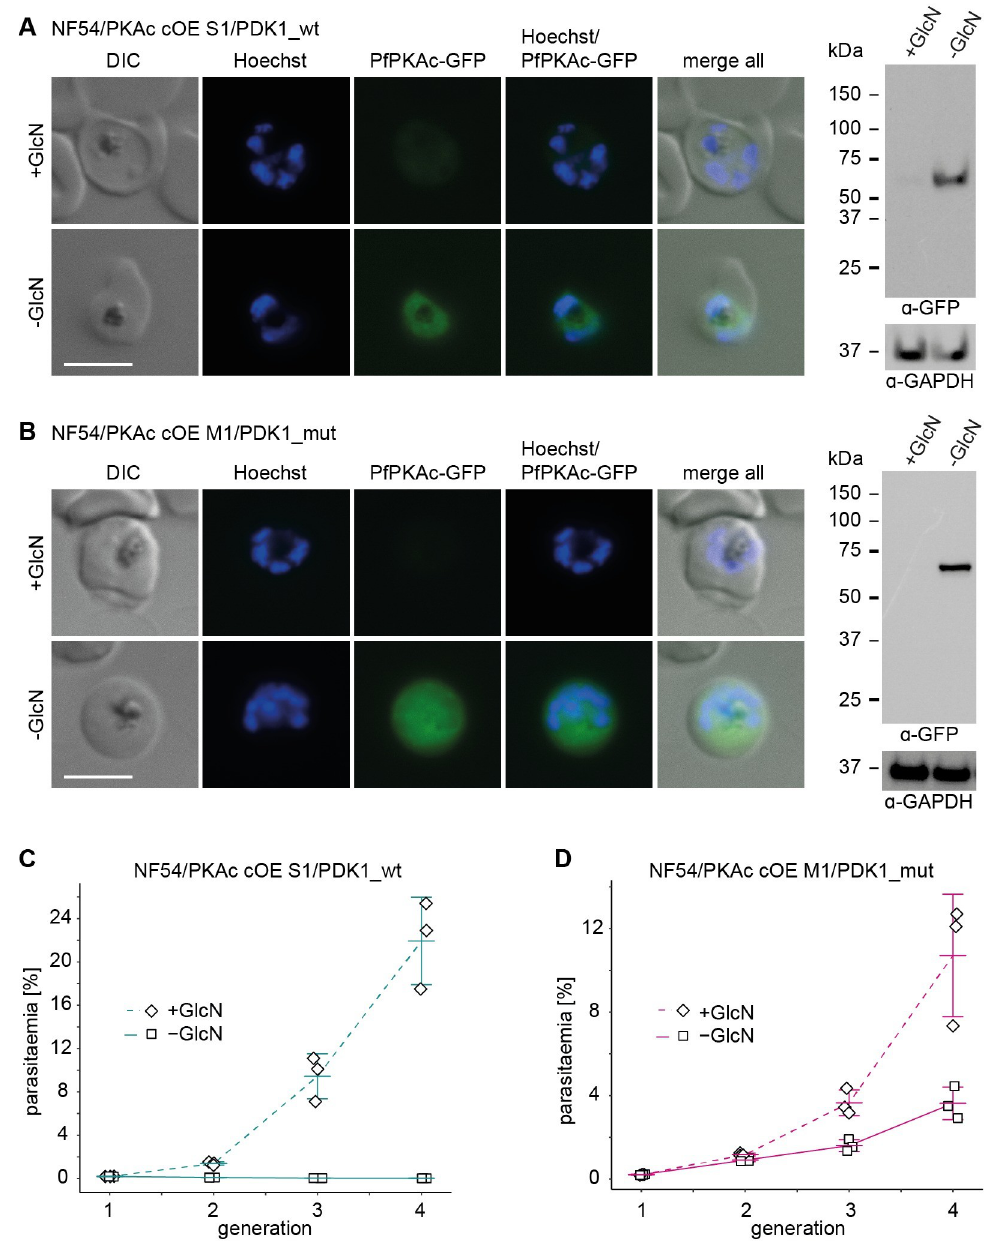
Fig 5. Targeted mutagenesis of PfPDK1 confirms its essential role in activating PfPKAc. (A, B) Expression of PfPKAc- GFP under OE-inducing (–GlcN) and control conditions (+GlcN) in NF54/PKAc cOE S1/PDK1_wt parasites (A) and NF54/PKAc cOE M1/PDK1_mut parasites (B) by live cell fluorescence imaging and western blot analysis. Synchronous parasites (0 to 8 hpi) were split ( ± GlcN) 40 hours before collection of the samples. Representative fluorescence images are shown. Parasite DNA was stained with Hoechst. Scale bar = 5 μ m. For western blot analysis, lysates derived from an equal number of parasites were loaded per lane. MW PfPKAc-GFP = 67.3 kDa, MW PfGAPDH = 36.6 kDa. The full size western blots are shown in S11 Fig. (C, D) Increase in parasitaemia of NF54/PKAc cOE S1/PDK1_wt parasites (C) and NF54/ PKAc cOE M1/PDK1_mut parasites (D) over 3 generations under PfPKAc-GFP OE-inducing (–GlcN) and control conditions (+GlcN). Synchronous parasites (0 to 6 hpi) were split ( ± GlcN) 18 hours before the first measurement in generation 1. Open squares represent data points for individual replicates and the means and SD (error bars) of 3 biological replicates are shown. The raw data are available in the source data file (S2 Data). DIC, differential interference contrast; GlcN, glucosamine.